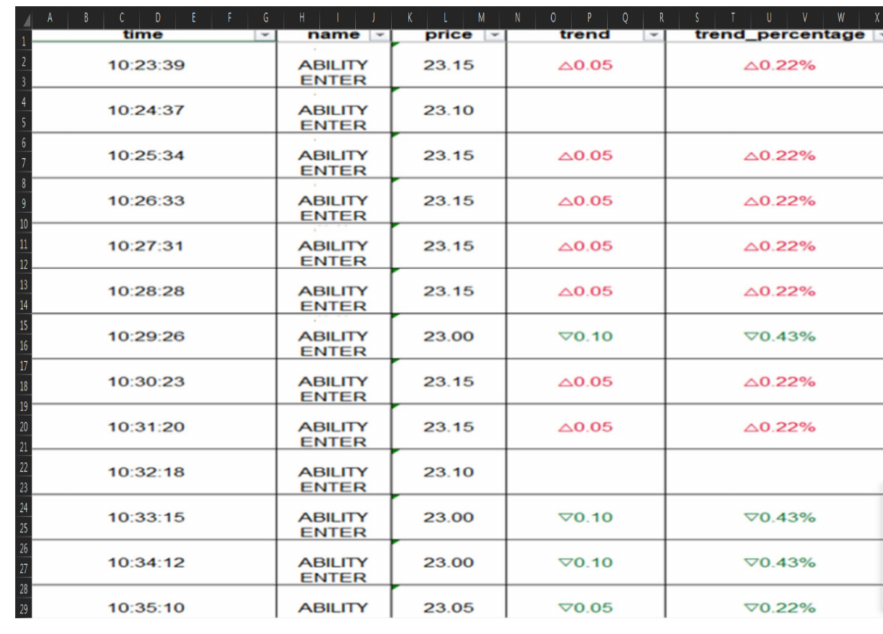
Figure 16. Timing mode is stop and then generate stock sequence to Excel format.